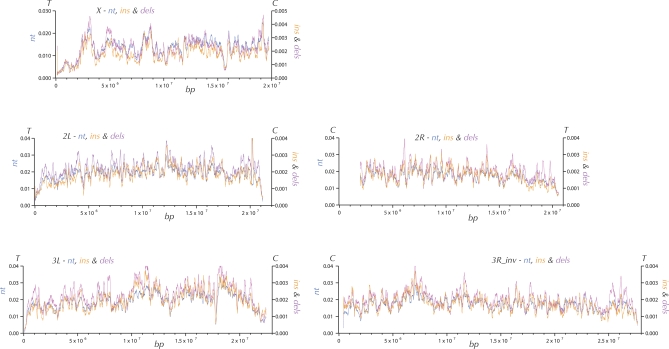
Patterns of Polymorphism for Nucleotides, Small Insertions, and Small Deletions along Chromosome Armsπ for nucleotides (blue), π for small (≤ 10 bp) insertions (orange), and π for small (≤ 10 bp) deletions (orchid) among the D. simulans lines in 150-kbp windows are plotted every 10 kbp (see Materials and Methods). C and T correspond to locations of centromeres and telomeres, respectively. Chromosome arm 3R coordinates correspond to D. simulans locations after accounting for fixed inversion on the D. melanogaster lineage.